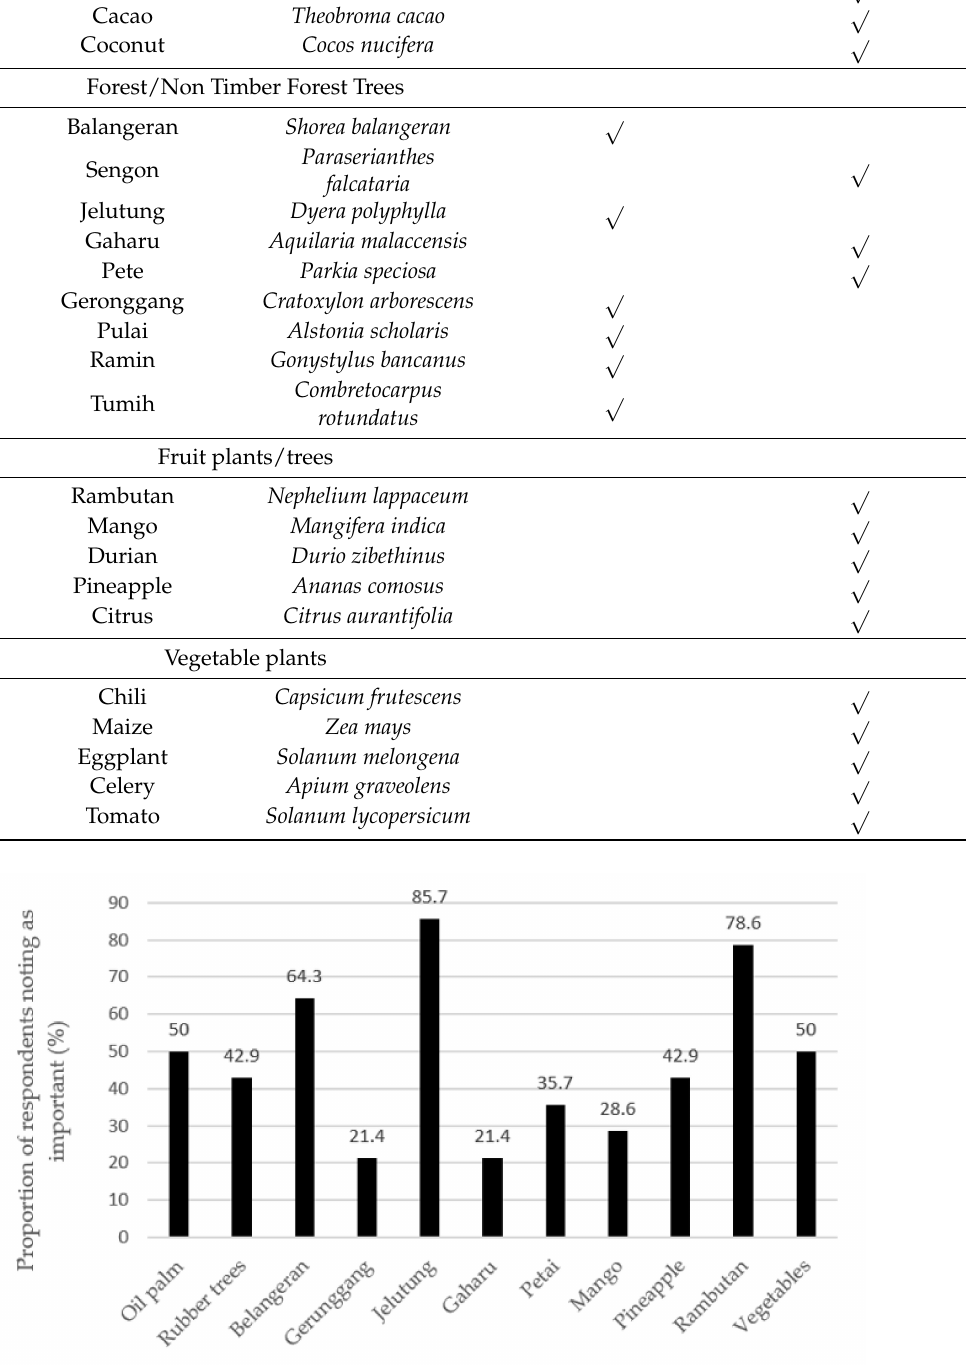
Figure 2. Proportion of times each species was noted as being important by the respondents. Note that species with only one mention in Table 2 were not included in this